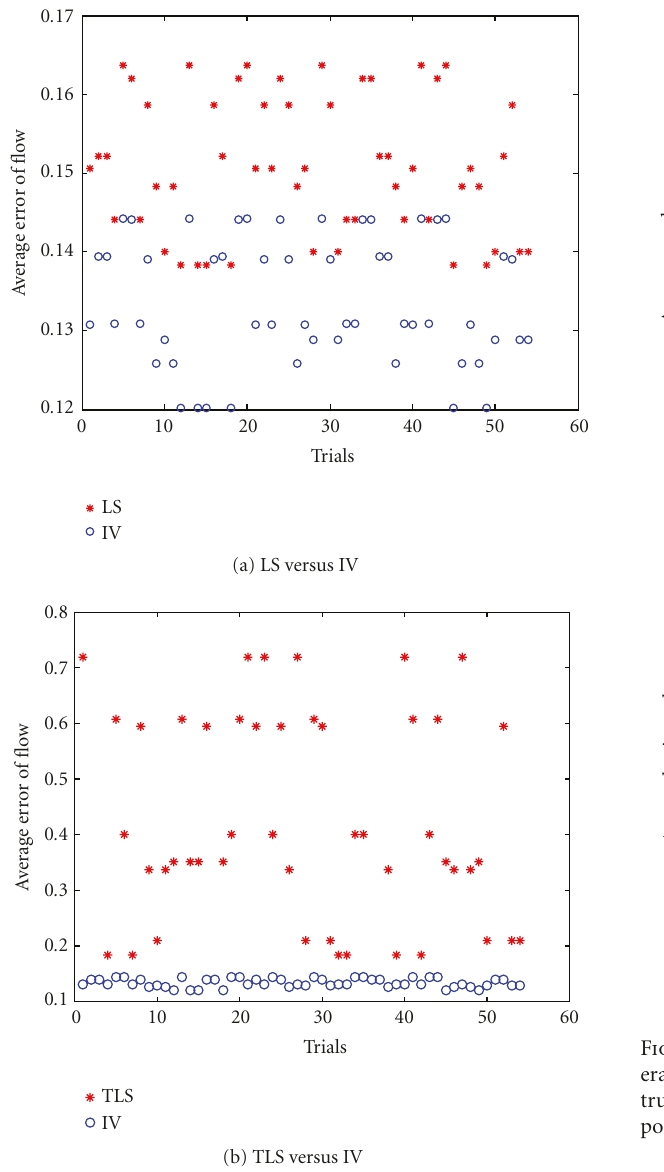
Figure 6: Performance comparison on the “o ffi ce” sequence using the Lucas-Kanade algorithm.